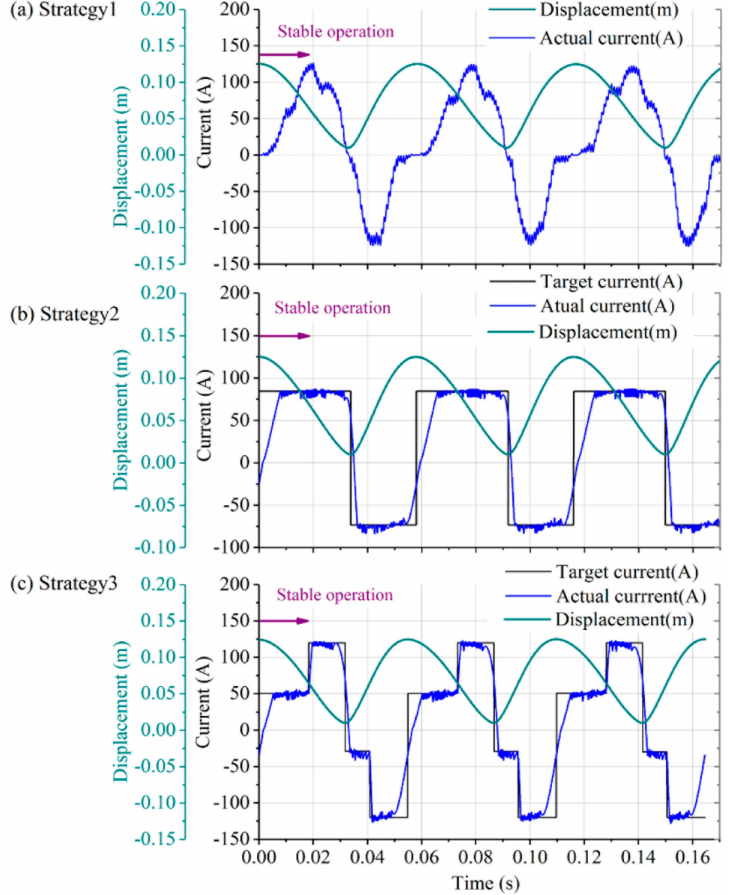
Figure 16. Three control strategies during the stable operation